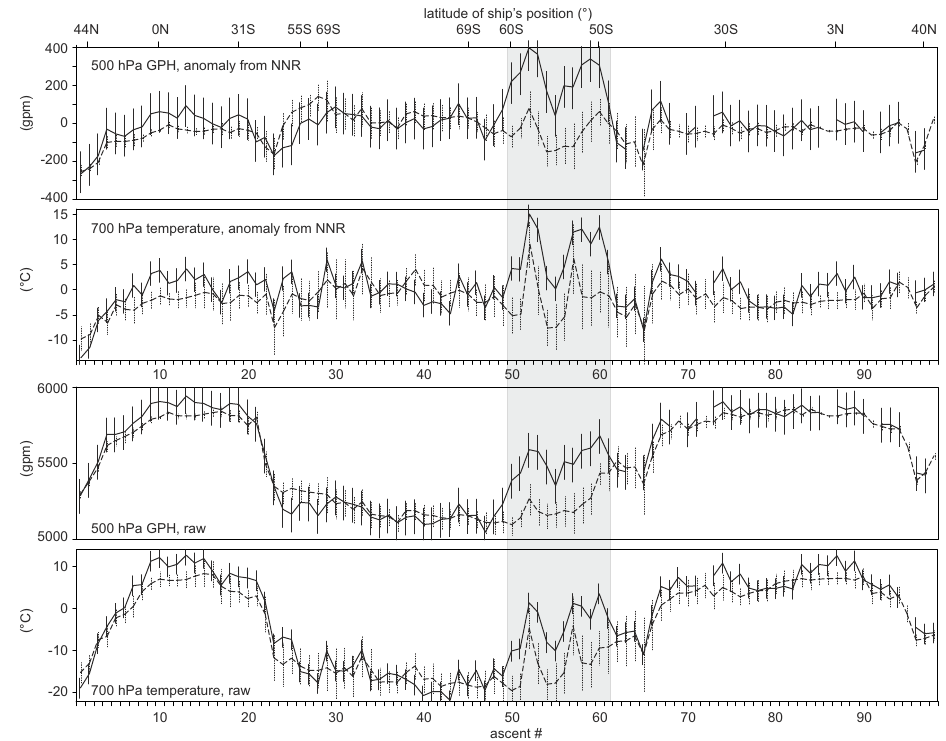
Fig. 4. 500hPa GPH and 700hPa temperature from the MS Schwabenland (solid lines) and 20CR (dashed lines) as a function of the ascent number. The top two panels display the data in the form of anomalies from the NNR climatology, the bottom two panels show the raw data. The vertical bars give 2 σ obs (solid) and 2 σ CR (grey dashed) respectively. The shaded region of ascents 50 to 61 highlights the suspected erroneous observations.